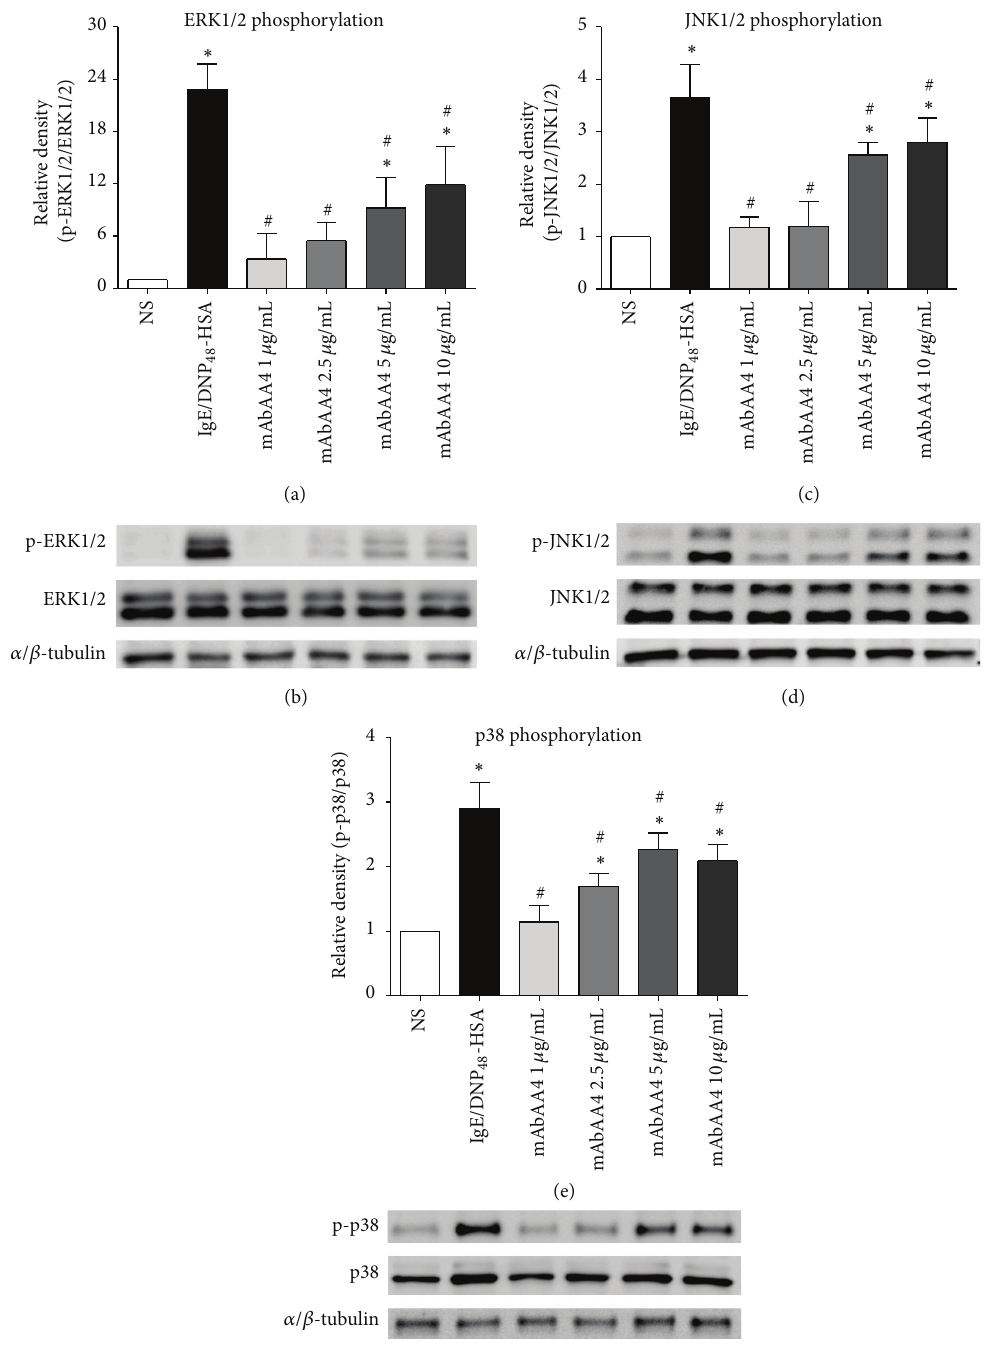
Figure 4: Cross-linking GD1b derived gangliosides with mAbAA4 induced MAP kinase phosphorylation in mast cells. RBL-2H3 cells were either stimulated via Fc 𝜀 RI, where cells were sensitized with IgE anti-TNP and stimulated with DNP 48 -HSA (50ng/mL) or incubated with mAbAA4 (1, 2.5, 5, and 10 𝜇 g/mL) for 10min. Total cell lysates were immunoblotted with antibodies against phospho-ERK1/2 (p-ERK1/2), ERK1/2, phospho-JNK1/2 (p-JNK1/2), JNK1/2, phospho-p38 (p-p38), p38, and 𝛼 / 𝛽 -tubulin (housekeeping protein) and the mean optical density of the bands was determined. Densitometry of the changes in expression and phosphorylation of proteins were corrected for 𝛼 / 𝛽 - tubulin. Data is expressed as the fold of nonstimulated (NS) cells. (a) Ratio of phosphorylated ERK1/2/total ERK1/2; (b) a representative blot from (a); (c) ratio of phosphorylated JNK1/2/total JNK1/2; (d) a representative blot from (c); (e) ratio of phosphorylated p38/total p38; (f) a representative blot from (e). Data is expressed as the mean ± SD of three independent experiments. ∗ 𝑃 < 0.05 between experimental samples and the nonstimulated (NS) cells. # 𝑃 < 0.05 between experimental samples and Fc 𝜀 RI stimulated